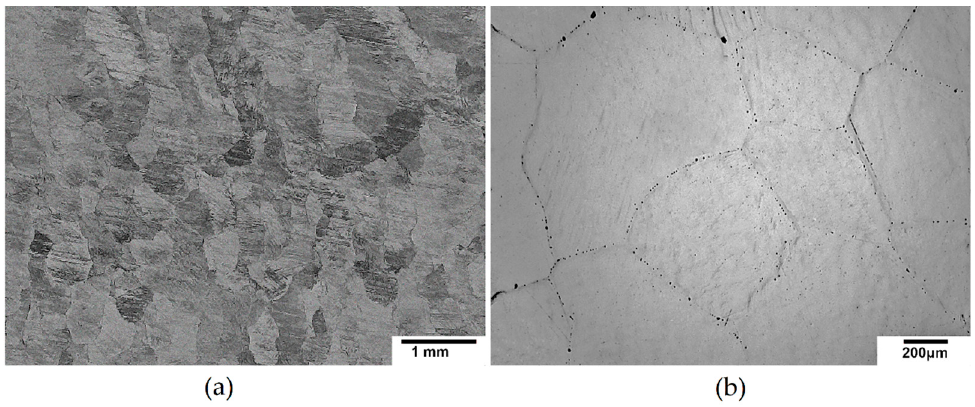
Figure 1. Light micrographs of initial as-cast material used ( a ) for rolling and ( b ) for extrusion. The main characteristics of sample structures were obtained by electron backscat- ter diffraction (EBSD) using a Tescan LYRA 3 XMU FEG/SEMxFIB electron